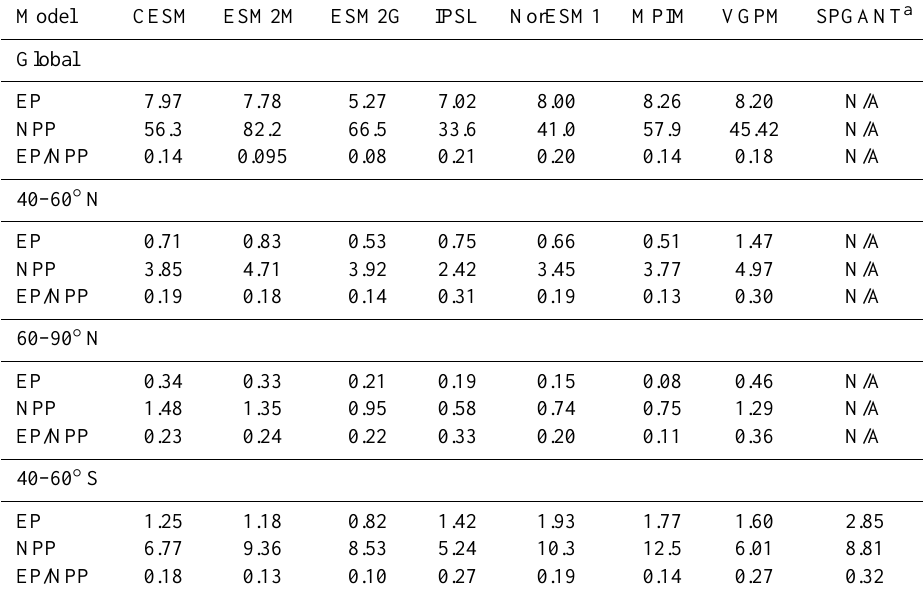
Table 1. Vertically integrated NPP, EP at 100m (both in PgCyr − 1 ) and EP/PP for six CMIP5 models and two satellite products.